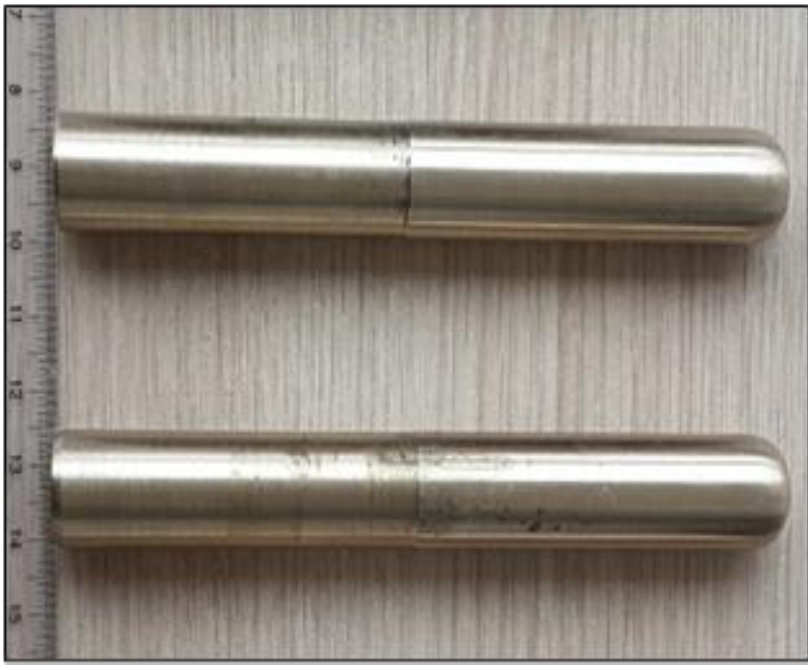
Figure 2. SAE 430B forming tools. Table 1. Composition of forming tool and workpiece as well as properties of oil used.